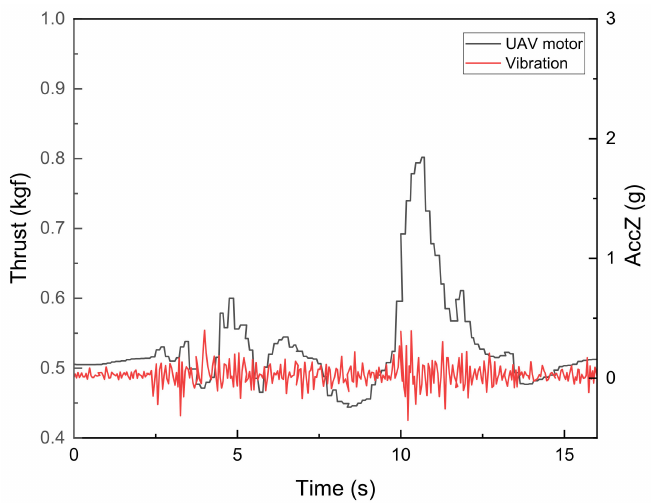
Figure 8. UAV thrust measured at the trackside on top of the Wolsan bridge during the passage of a KTX